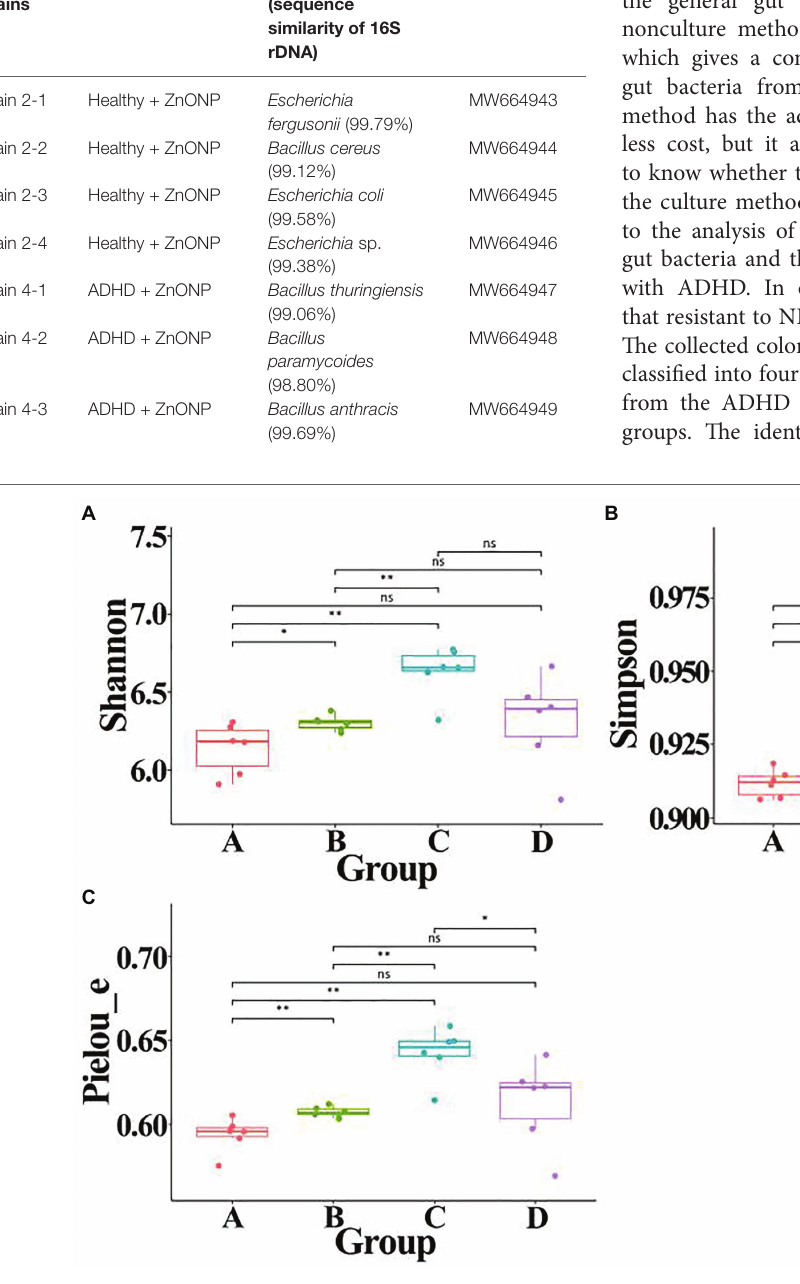
TABLE 1 | Sequence similarity of the main representative strains from the fecal samples of the healthy and ADHD children. Bacterial Sources Bacterial identity Accession no. strains (sequence similarity of 16S rDNA)